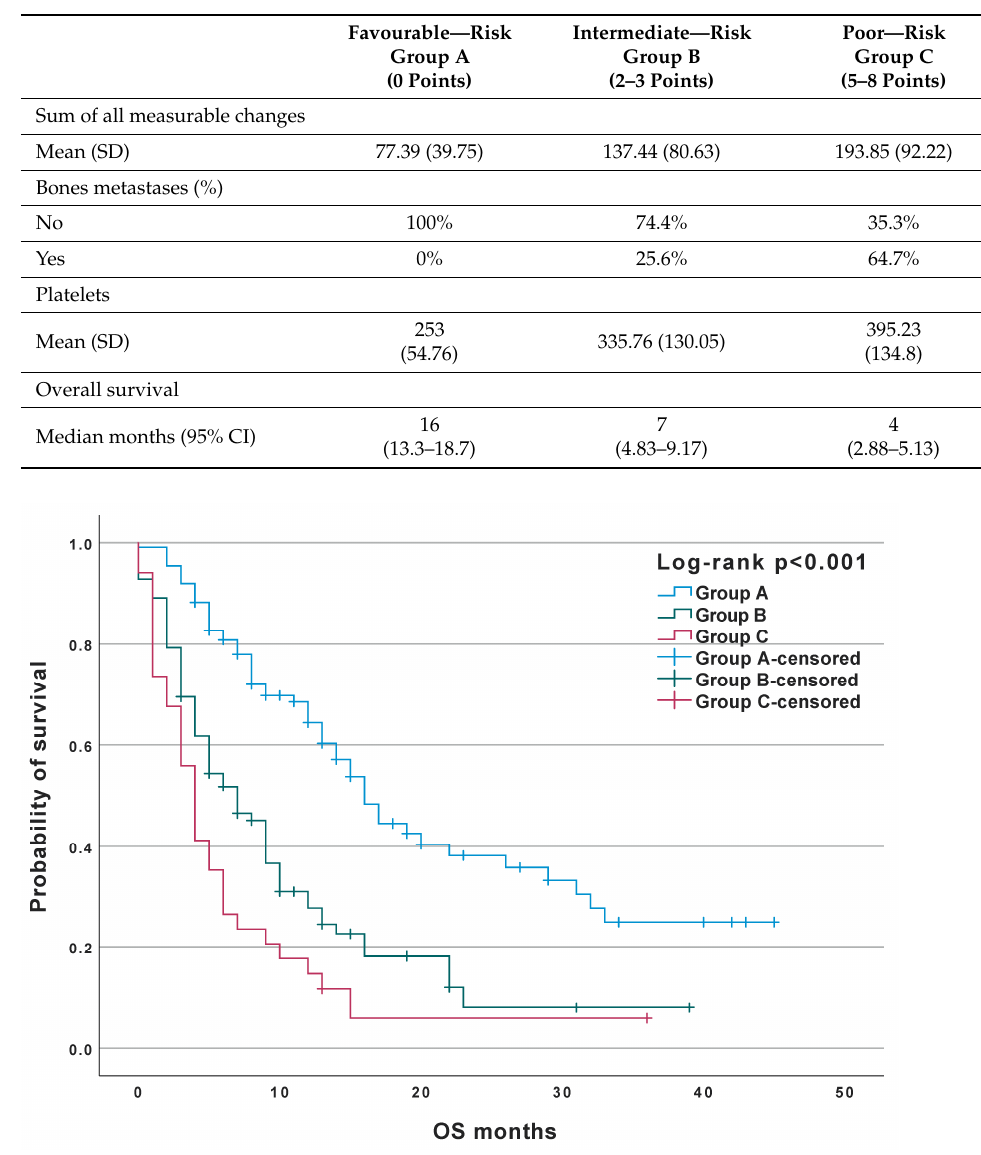
Figure 3. Probability of survival in the prognostic groups.